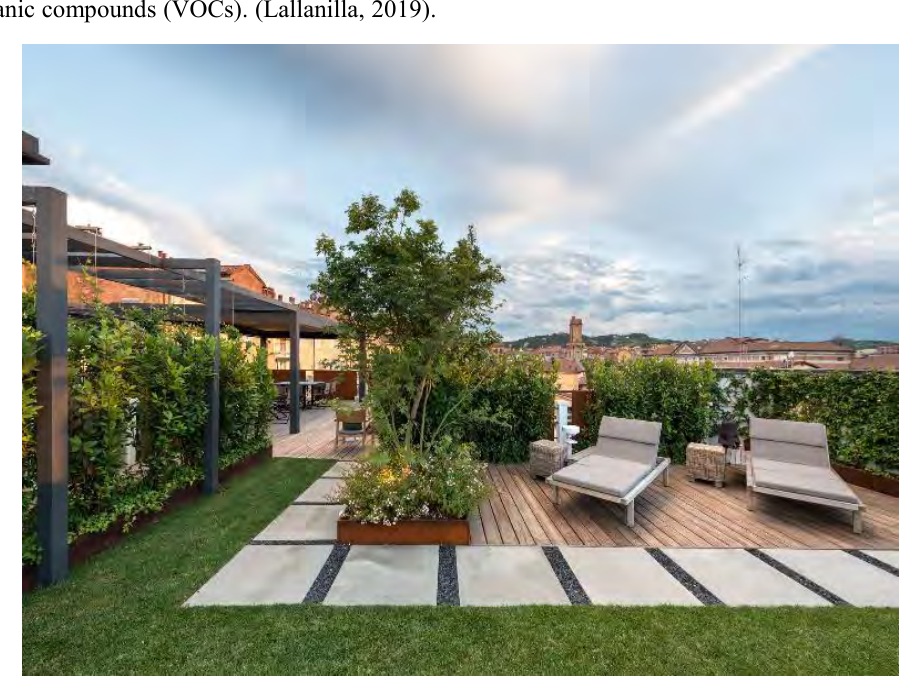
Fig. 13: Hotel Metropolitan 5th floor roof garden, Bologna. (Gianclaudio,